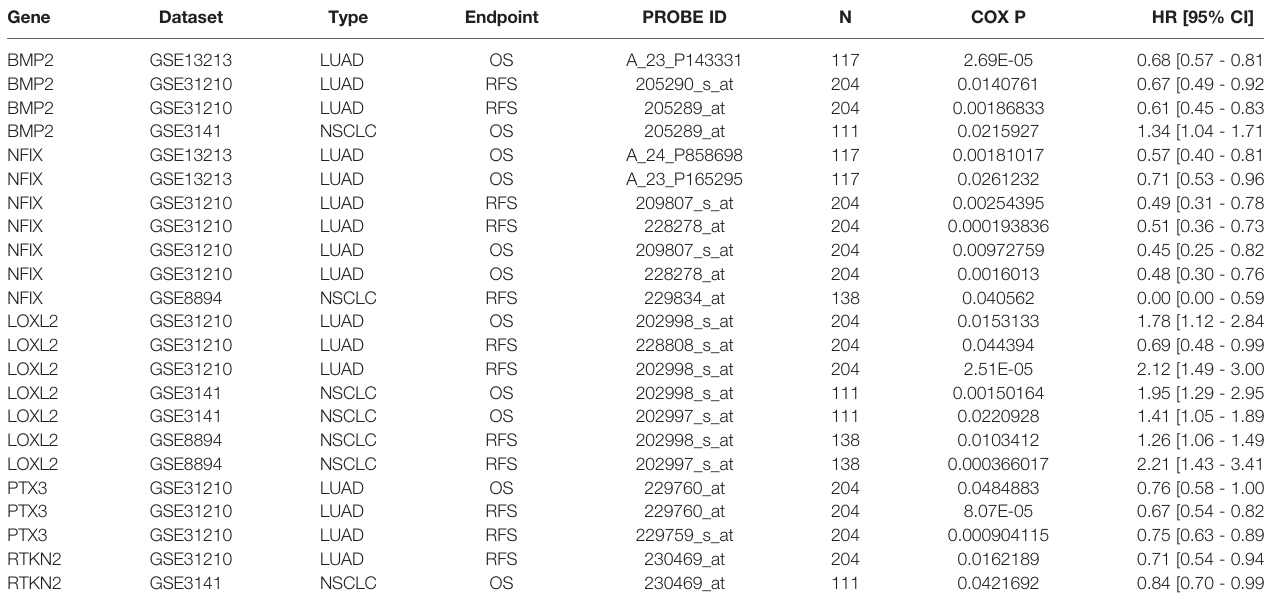
TABLE 4 | The expression levels of RTKN2, NFIX, PTX3, BMP2 and LOXL2 were correlated with poor prognosis of NSCLC patients in the PrognoScan databases.